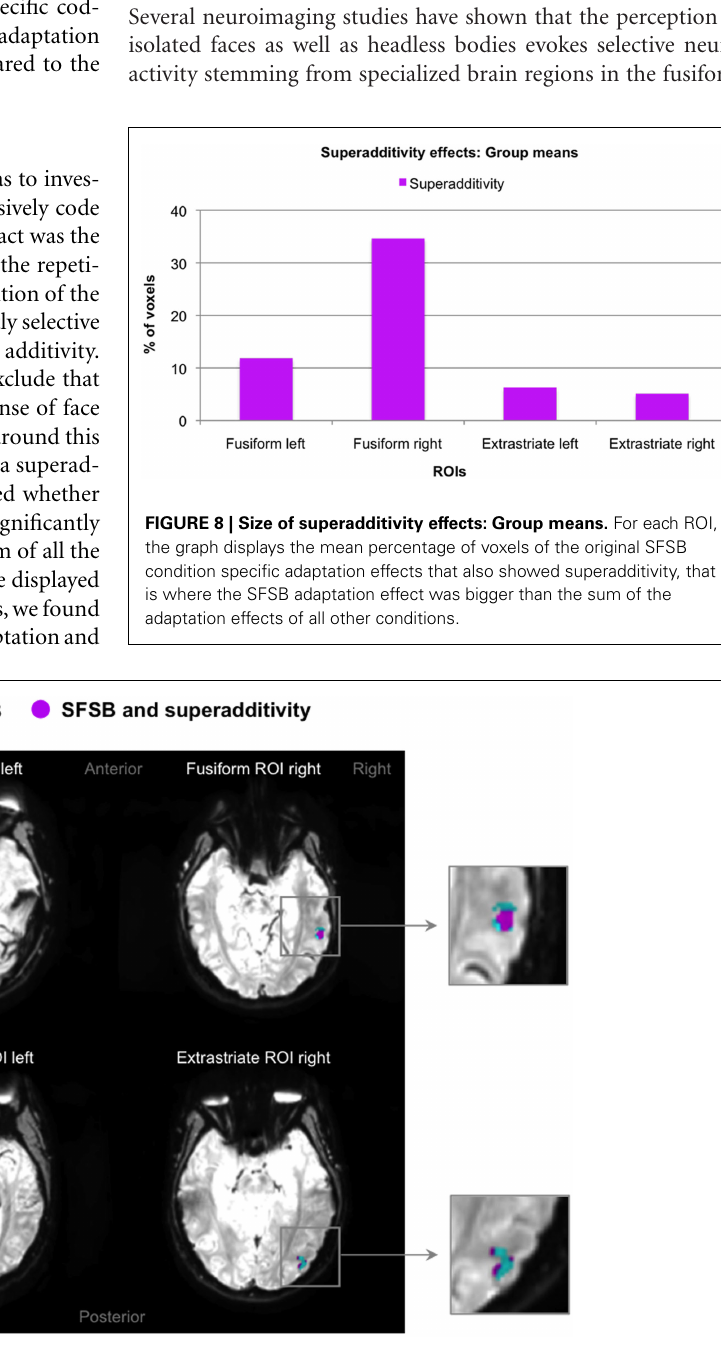
FIGURE 7 | Superadditivity effects in fusiform and extrastriate ROIs. Four examples of activation maps, one for each ROI, showing SFSB condition specific adaptation effects as well as SFSB superadditivity adaptation effects displayed on functional image slices. (cid:2) :Voxels showing SFSB adaptation;